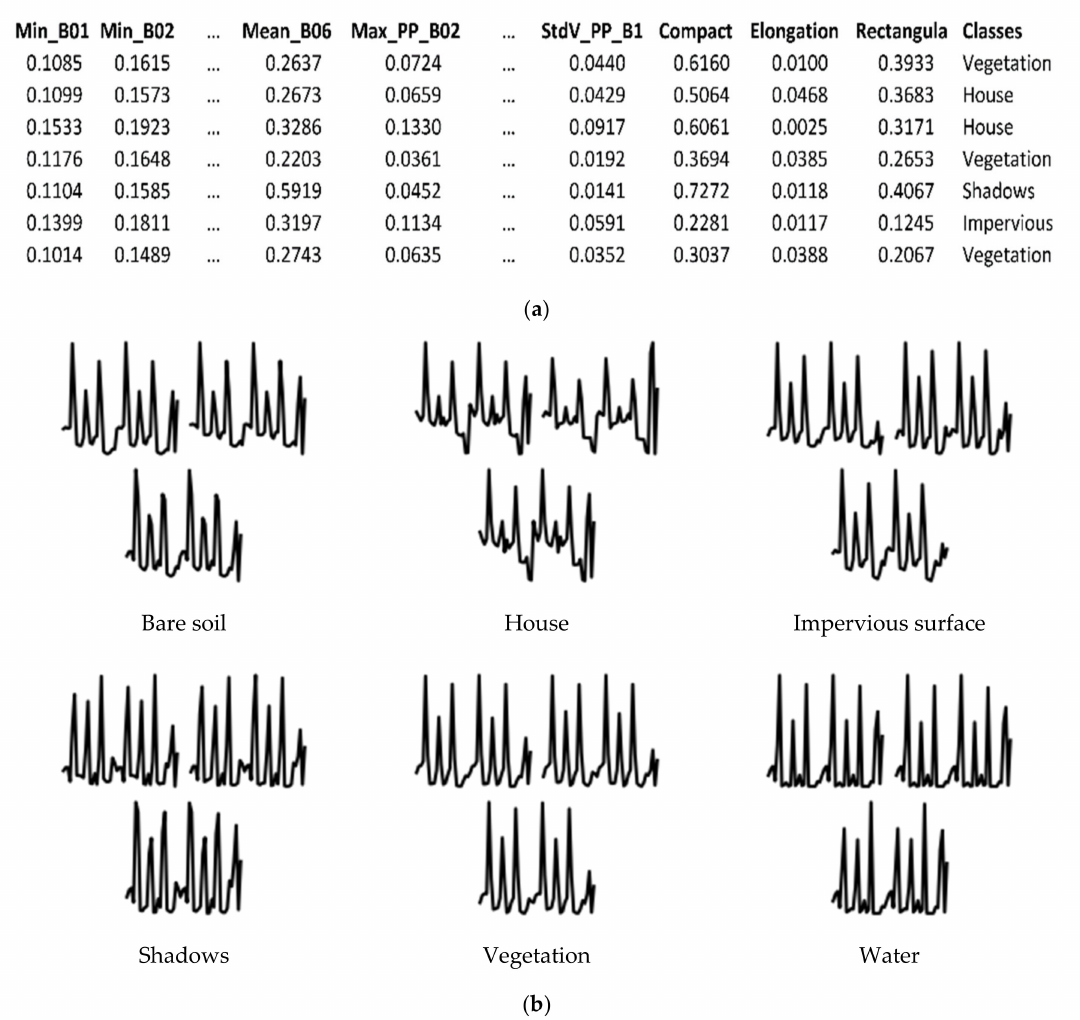
Figure 5. Examples of graphs representing variations of the object’s attributes. The graphs in ( b ) were used for CNN-based gradient boosting algorithms. The original tabulated data in ( a ) were used to learn these algorithms for